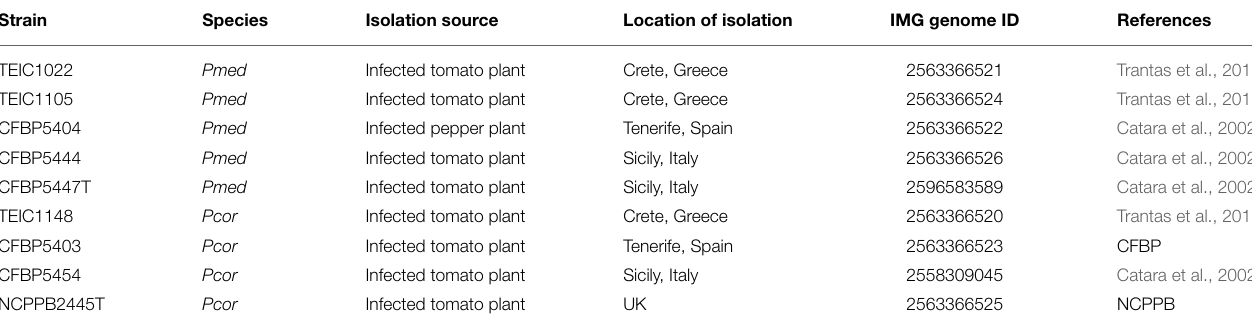
TABLE 1 | Strains used for the comparative analysis of Pseudomonas corrugata ( Pcor ) and P. mediterranea ( Pmed ).